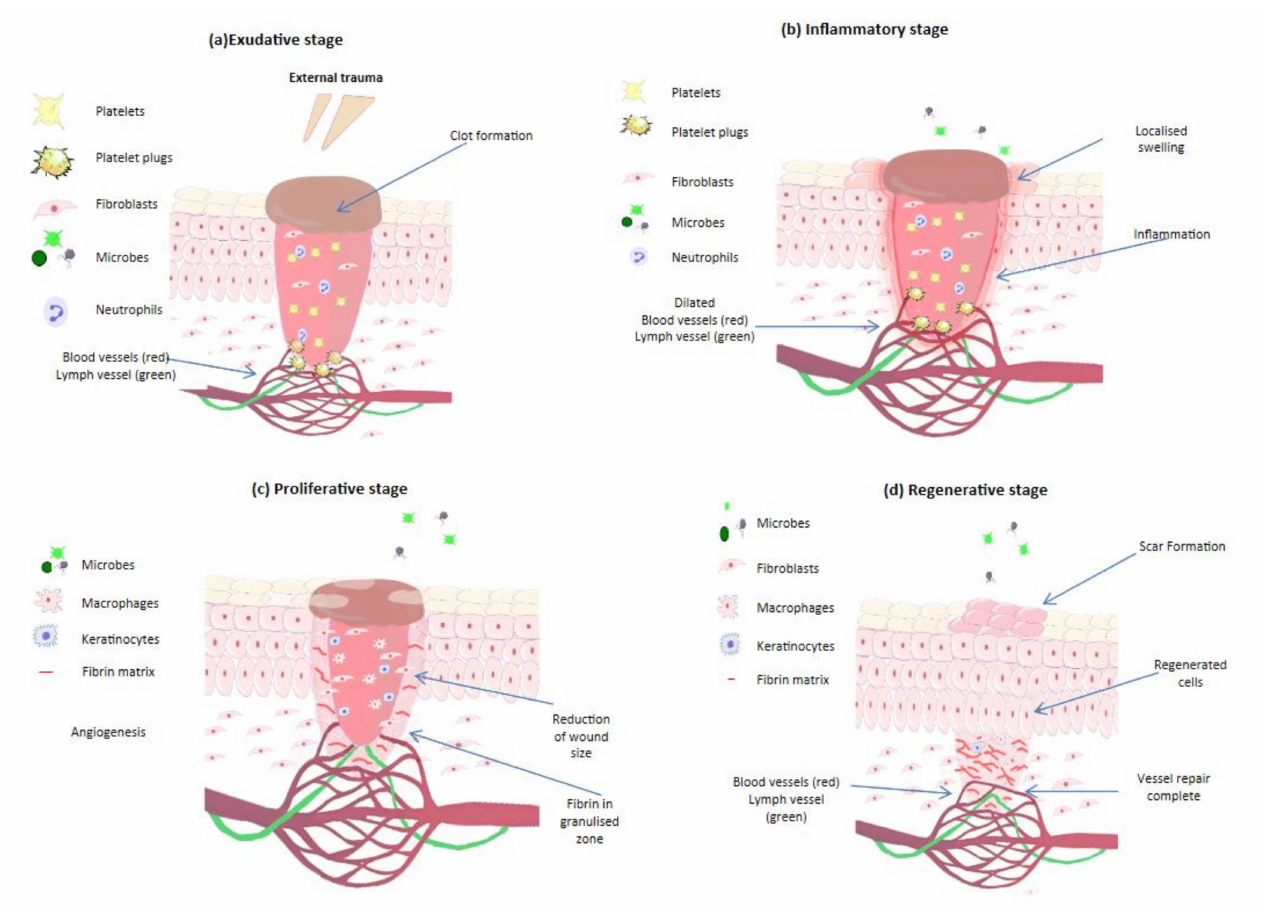
Figure 7. Illustration of the stages of wound healing: ( a ) exudative stage with the formation of a blood clot, ( b ) inflam- matory stage, marked with edema, pain, and inflammation, ( c ) proliferation stage with granulation tissue formation, and ( d ) regenerative stage, characterized by scar tissue formation. Reprinted with permission from ref. [102]. Copyright 2018